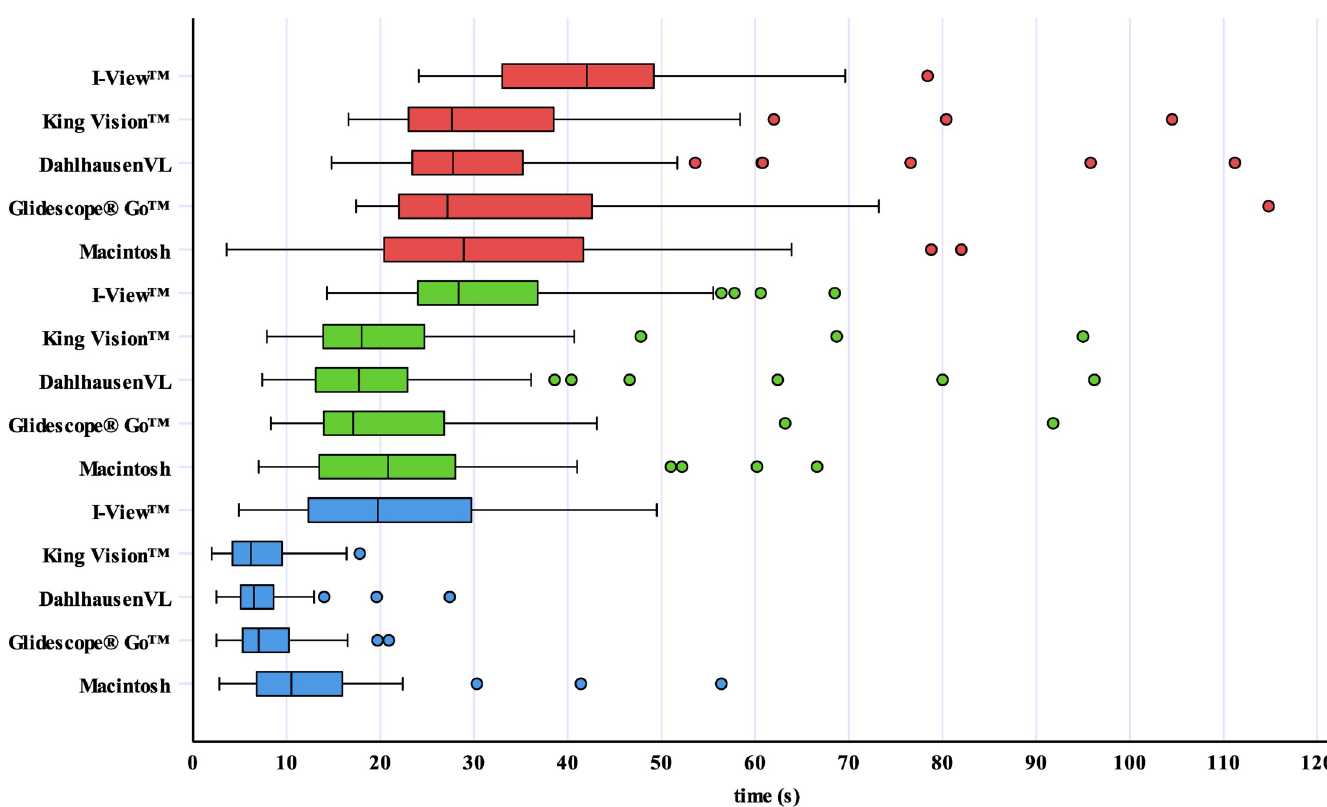
Fig 3. Recorded intubation times of the anesthetists with extensive previous experience in conventional and video laryngoscopy. Data are presented as boxplots that indicate the median (middle line), the 25 th and the 75 th percentile (box boundaries), the upper and lower limits within 1.5 times inter-quartile range (whiskers) and outliers (circles). The blue boxplots represent the “time to vocal cords”, the green boxplots represent the “time to intubate” and the red boxplots represent the “time to